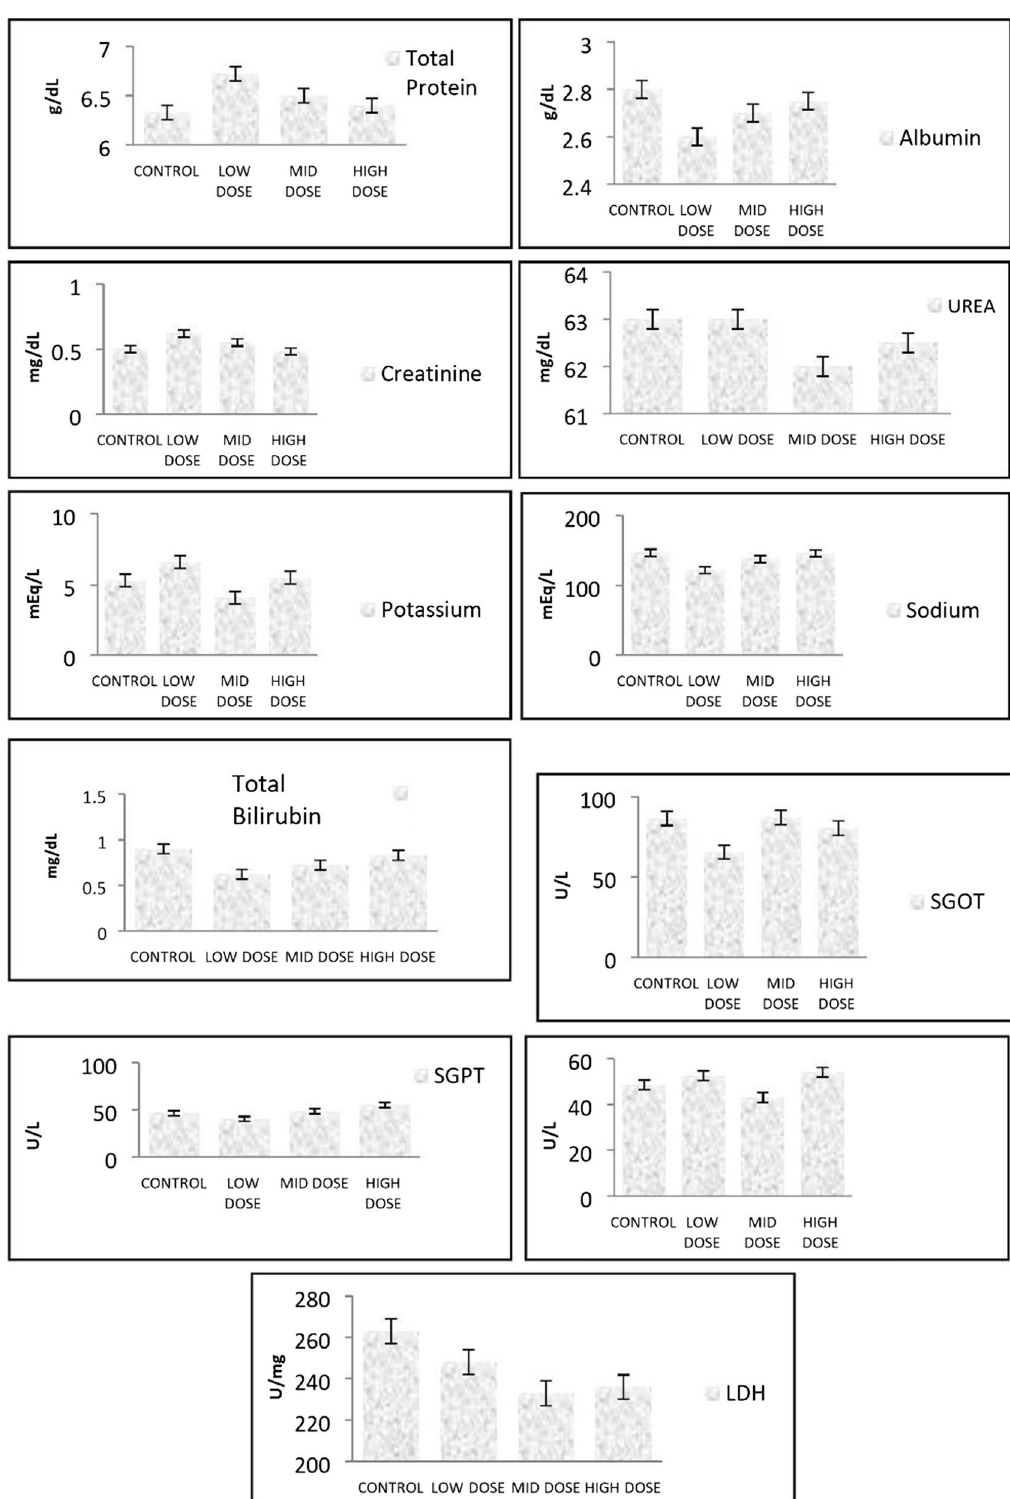
Fig. 9 Effect of T. viride on biochemical kidney/liver